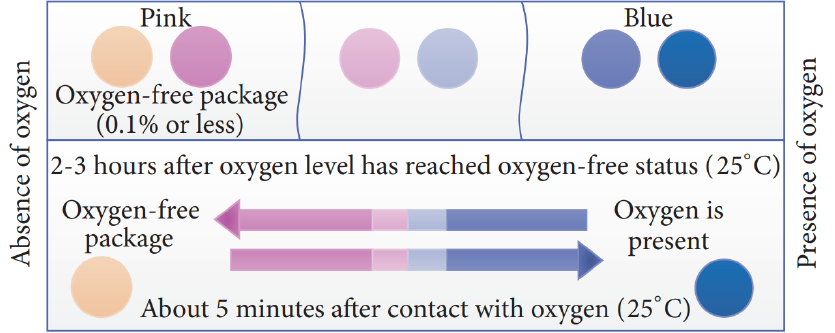
Figure 6. Schematic representation of the leak indicators, reproduced from [35].